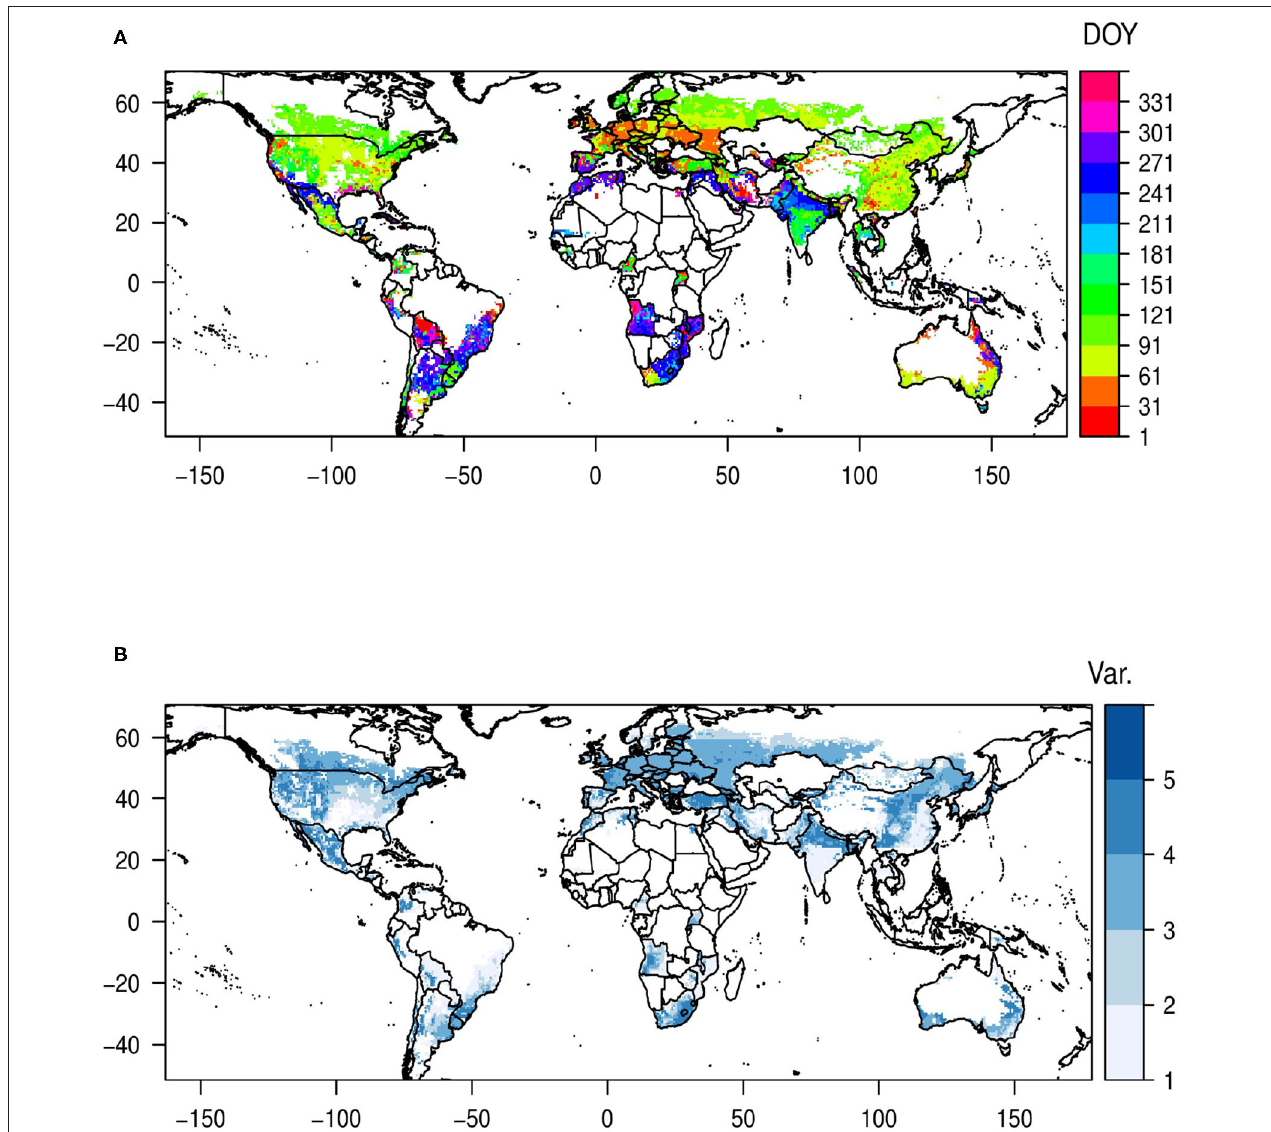
FIGURE 3 | (A) Start of selected planting window. (B) Variety chosen for each grid cell in the baseline climate.